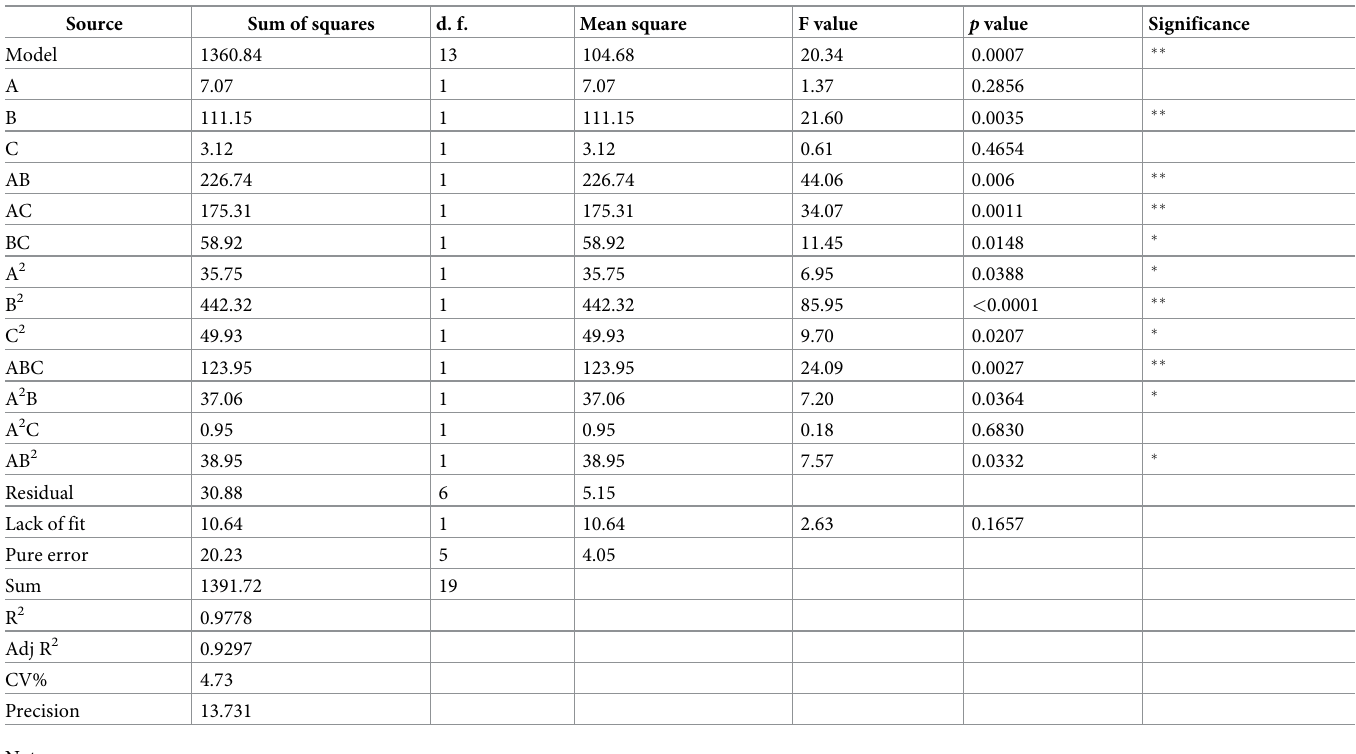
Table 4. Analysis of variance for